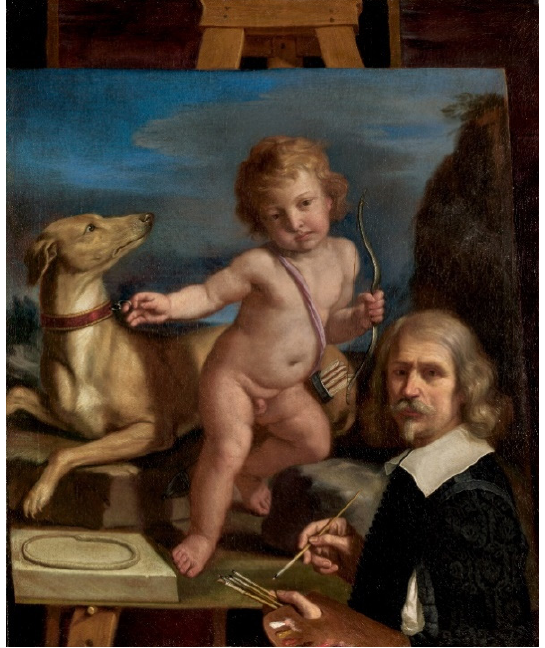
Figure 13. Guercino, Self-Portrait before a Painting of “Amor Fedele” , 1654/5, National Gallery, Wash- ington DC. Digital image courtesy of the National Gallery of Art, Washington Open Access Program.